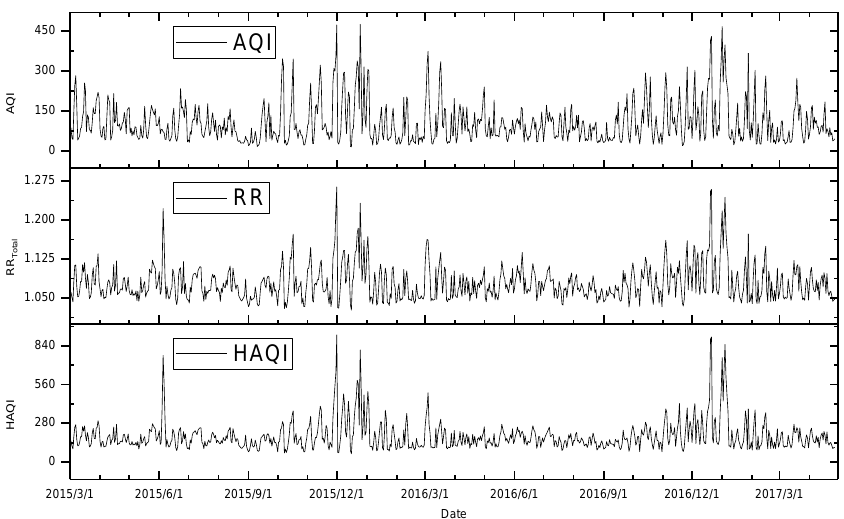
Figure 7. Curves of AQI, HAQI, and relative risk (RR Total ) according to their daily data during the study period.